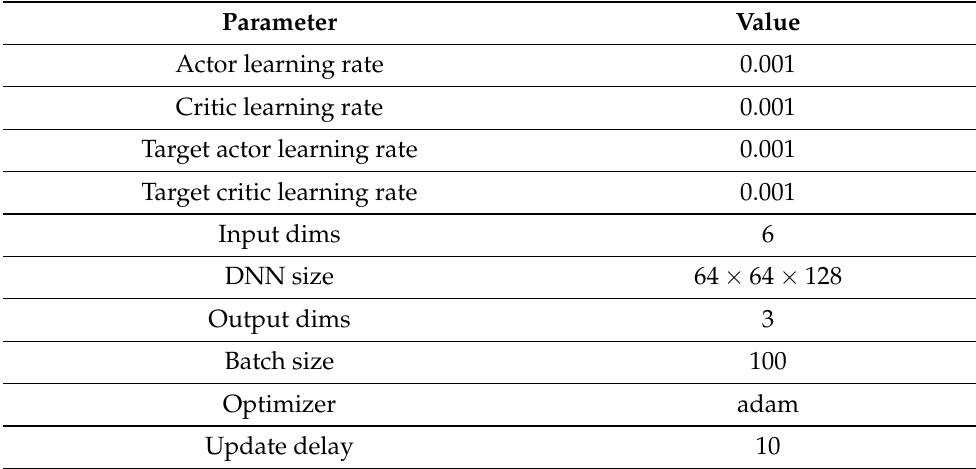
Table 3. Network parameter